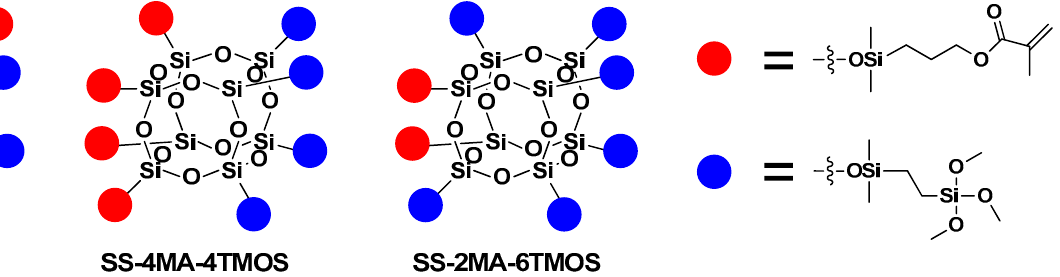
Figure 2. Idealized structures of the spherosilicate compounds used in this work.